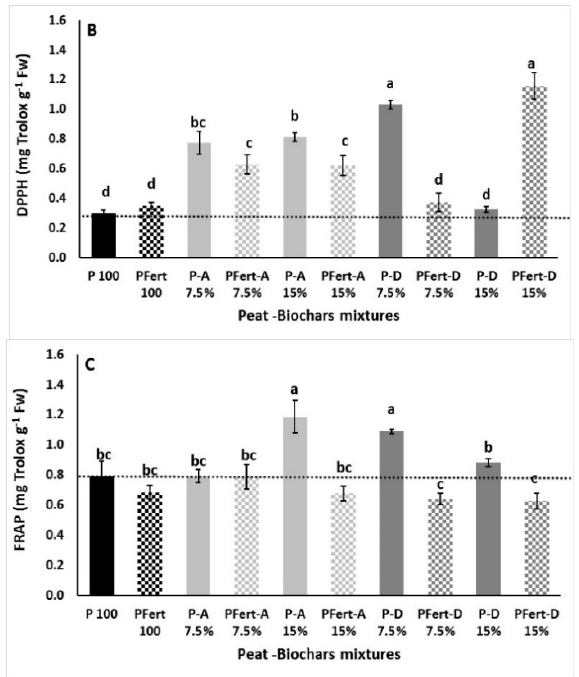
Figure 2. Effects of peat (P 100) with different biochar types (A, D) and ratio (7.5%, 15%) and mineral doses (with standard or with additional Fertilizers-Fert.) on cabbage total phenols and antioxidant activity. ( A ) total phenols, ( B ) DPPH, ( C ) FRAP. Significant differences ( p < 0.05) among treatments are indicated by different letters. Error bars show SE ( n = 4). Dotted line present the levels of control treatment (100% peat).